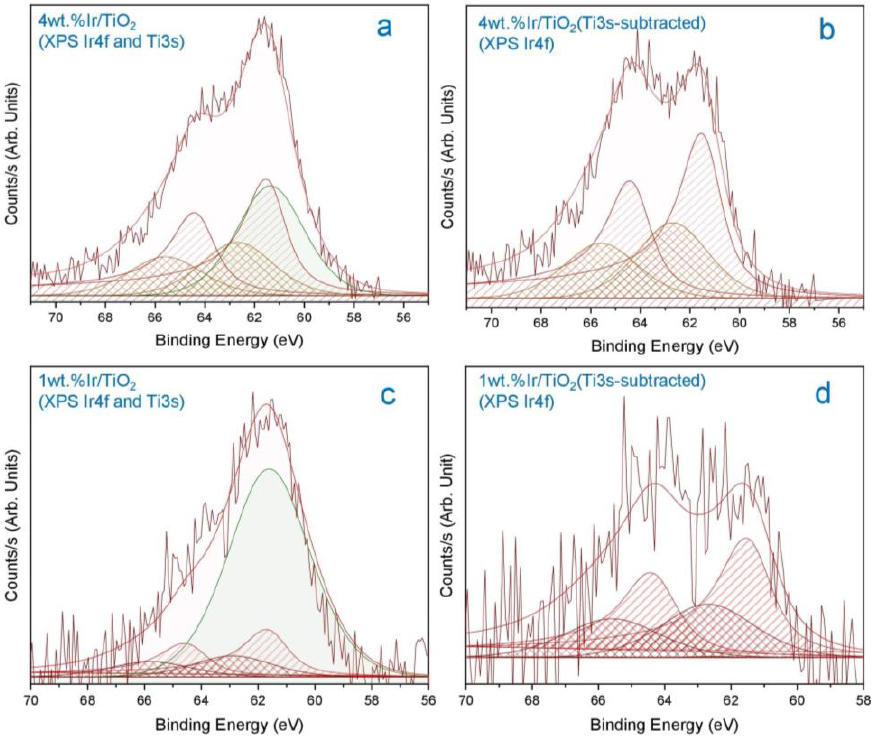
Figure 3. XPS spectra of the Ir 4f region of 4 wt.% IrO 2 /TiO 2 (anatase) ( a ) before and ( b ) after Ti 3s subtraction. XPS spectra of the Ir 4f region of 1 wt.% IrO 2 /TiO 2 (anatase) ( c ) before and ( d ) after Ti 3s subtraction (the Ti3s peak is shown in green in each).